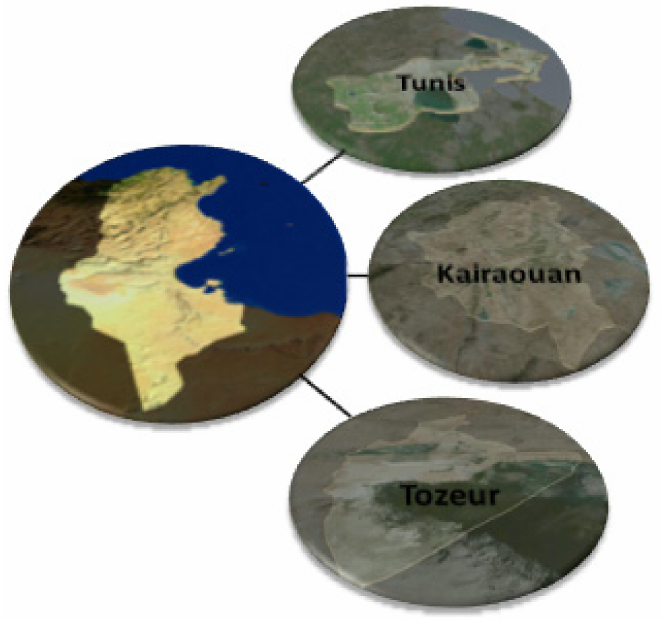
Figure 7. Tunisian studied regions.